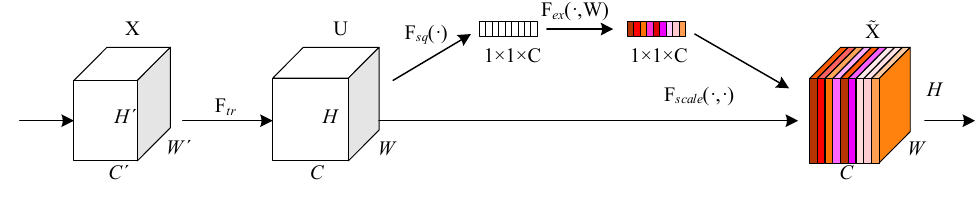
Figure 9. S.E. Module.